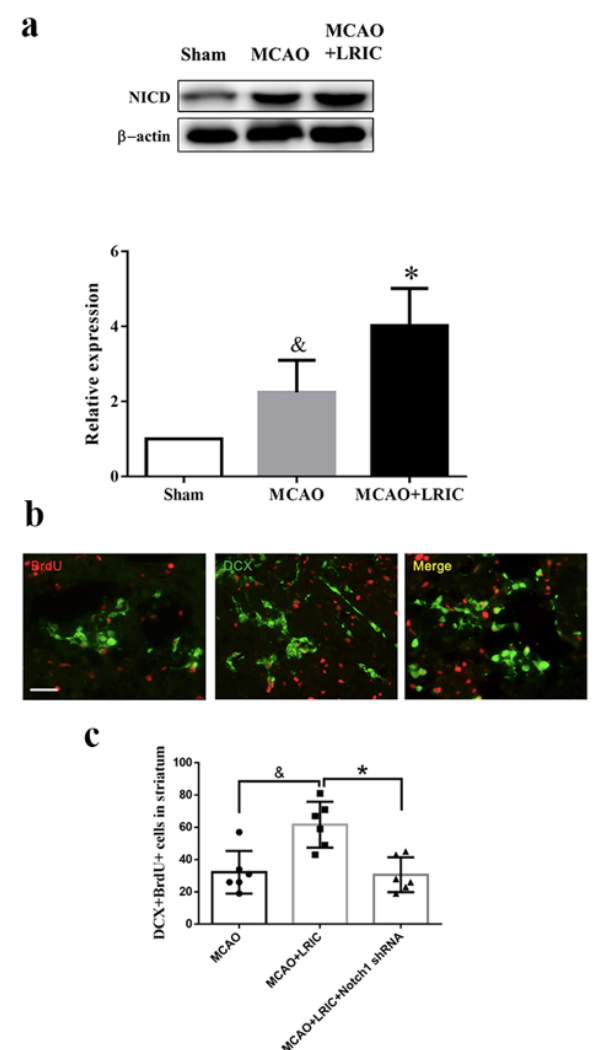
Figure 5. LRIC promoted activated Notch1 (NICD) protein expression in SVZ, and Noth1 shRNA abolished the beneficial effects of LRIC on proliferation of neuronal stem cells in MCAO mice. ( a ) Western blot detection of NICD expression in SVZ and showing the semi-quantitative results of protein expression in the bar graph. N = 6 per group, * p < 0.05. vs. MCAO group, and p < 0.01. vs. sham group. ( b ) Representation of immunofluorescence double staining. Scale bar = 100 mm. ( c ) Bar graph shows the number of DCX/BrdU double-positive cells. N = 6 per group. * p < 0.05, and &, p < 0.05.